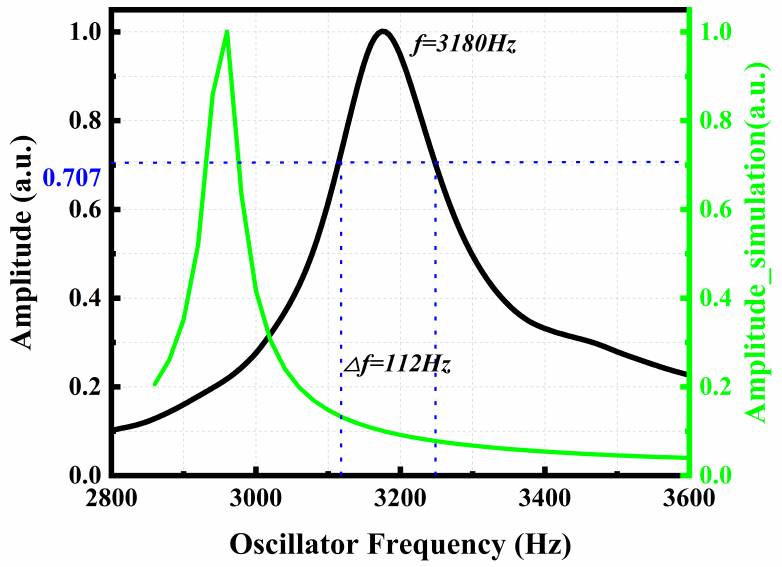
Figure 3. The real (black line) and simulation (green line) first order resonant frequency of